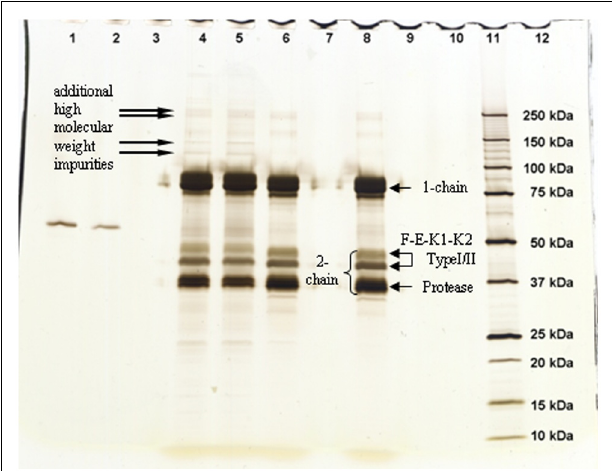
FIGURE 3 | Silver staining of gel from SDS electrophoresis under reducing conditions to detect tenecteplase aggregates and fragments. Lanes: 1–2 bovine serum albumin staining control; 4 Elaxim #140903; 5 Elaxim #140904E04; 6 Metalyse; 8 reference standard; 11 molecular weight markers.The right-facing arrows point to additional high molecular weight impurities.